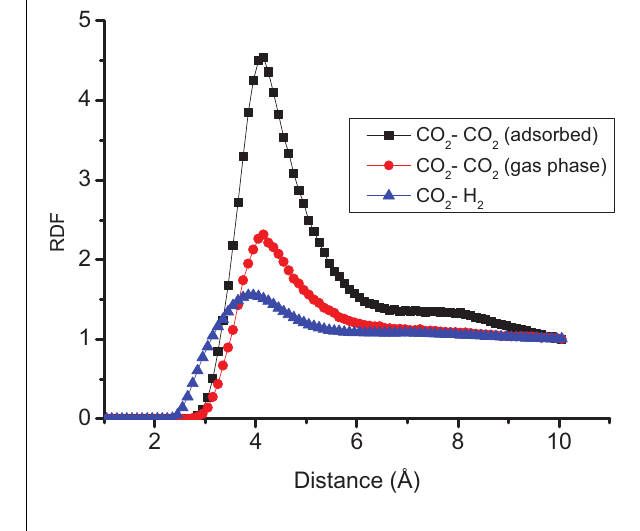
FIGURE 5 | Radial distribution function RDF of CO 2 –H 2 , CO 2 –CO 2 in the adsorbed layer and CO 2 –CO 2 in the gas phase at system T = 300K, N = 700, and x CO 2 = 0 .